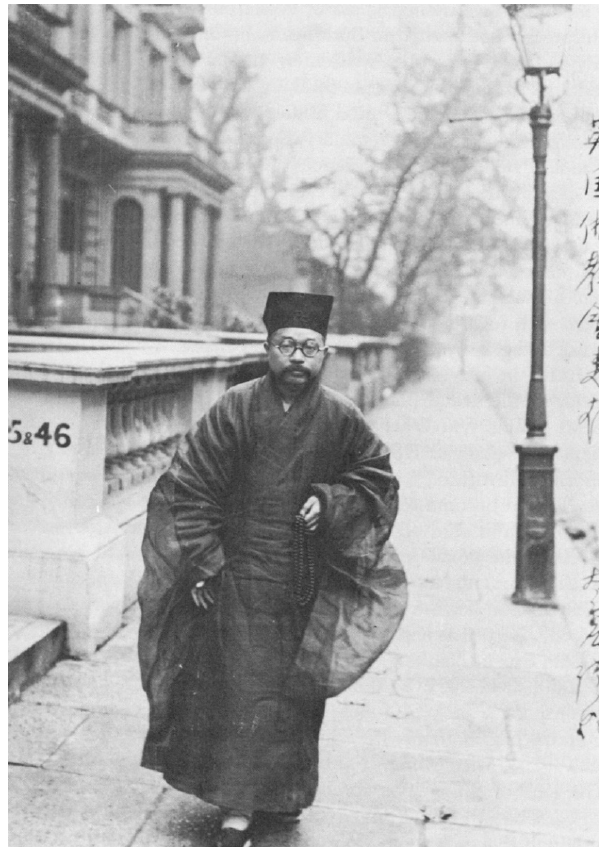
Figure 3. Master Taixu in London, 1929. Source: Holmes Welch, The Buddhist Revival in China (Harvard University Press, 1968), p. 61.